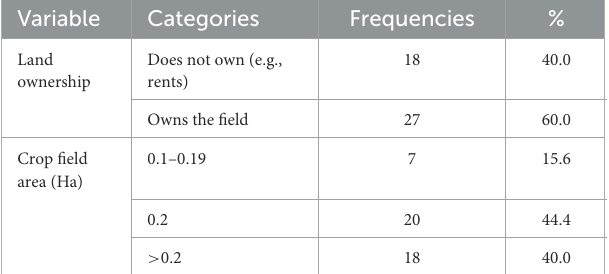
TABLE 2 Land ownership and land size of respondents for 45 farmers with maize and bean fields in Narumu Ward, Kilimanjaro Region, Tanzania.